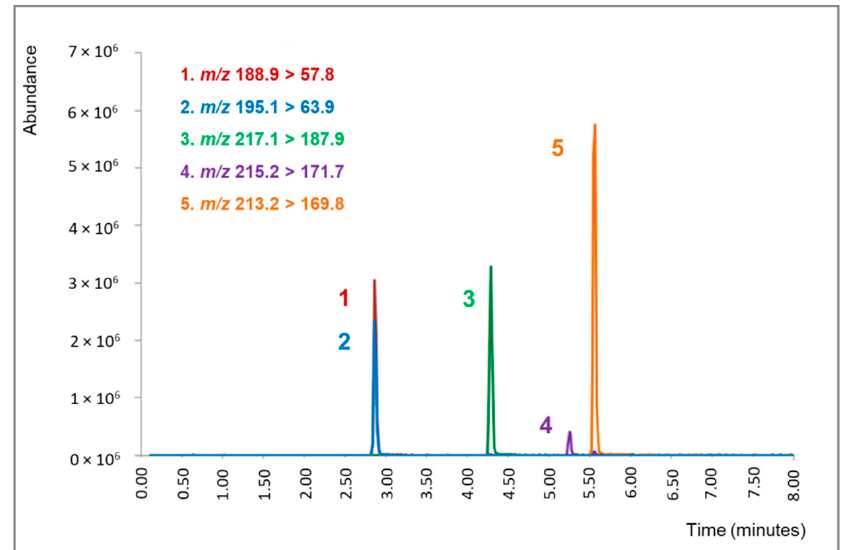
Figure 2. Chromatogram obtained from an ayahuasca sample containing 1. dimethyltryptamine (DMT, 223.0 ng / mL), 2. DMT- d 6 (internal standard), 3. tetrahydroharmine (THH, 226.5 ng / mL), 4. harmaline (HRL, 45.1 ng / mL) and 5. harmine (HRM, 257.5 ng / mL) after the dilute-and-shoot procedure. The m / z shown above was used for the quantification of the analytes.